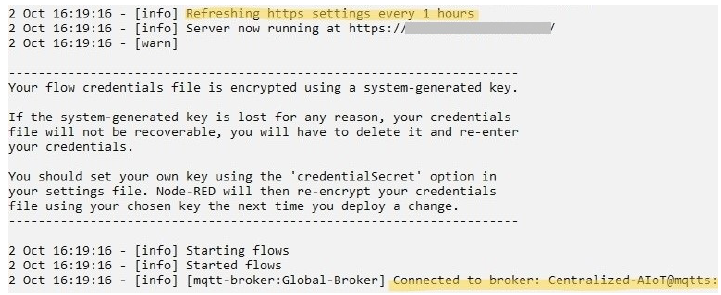
Figure 12. Verifying server certificate.